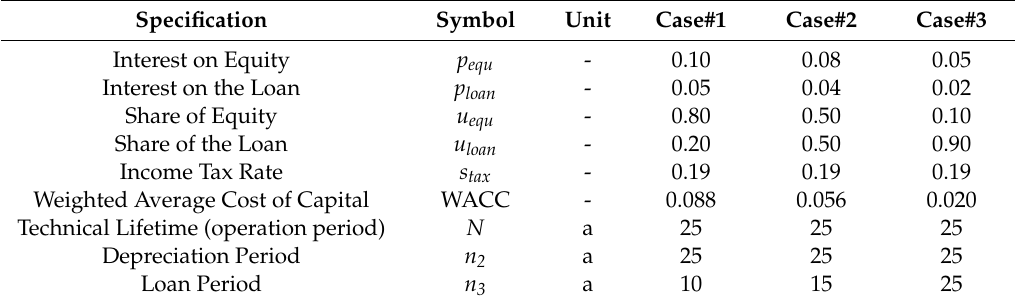
Table 3. General data for the PV-BESS system operating in the balancing group selling electricity to the DAM.